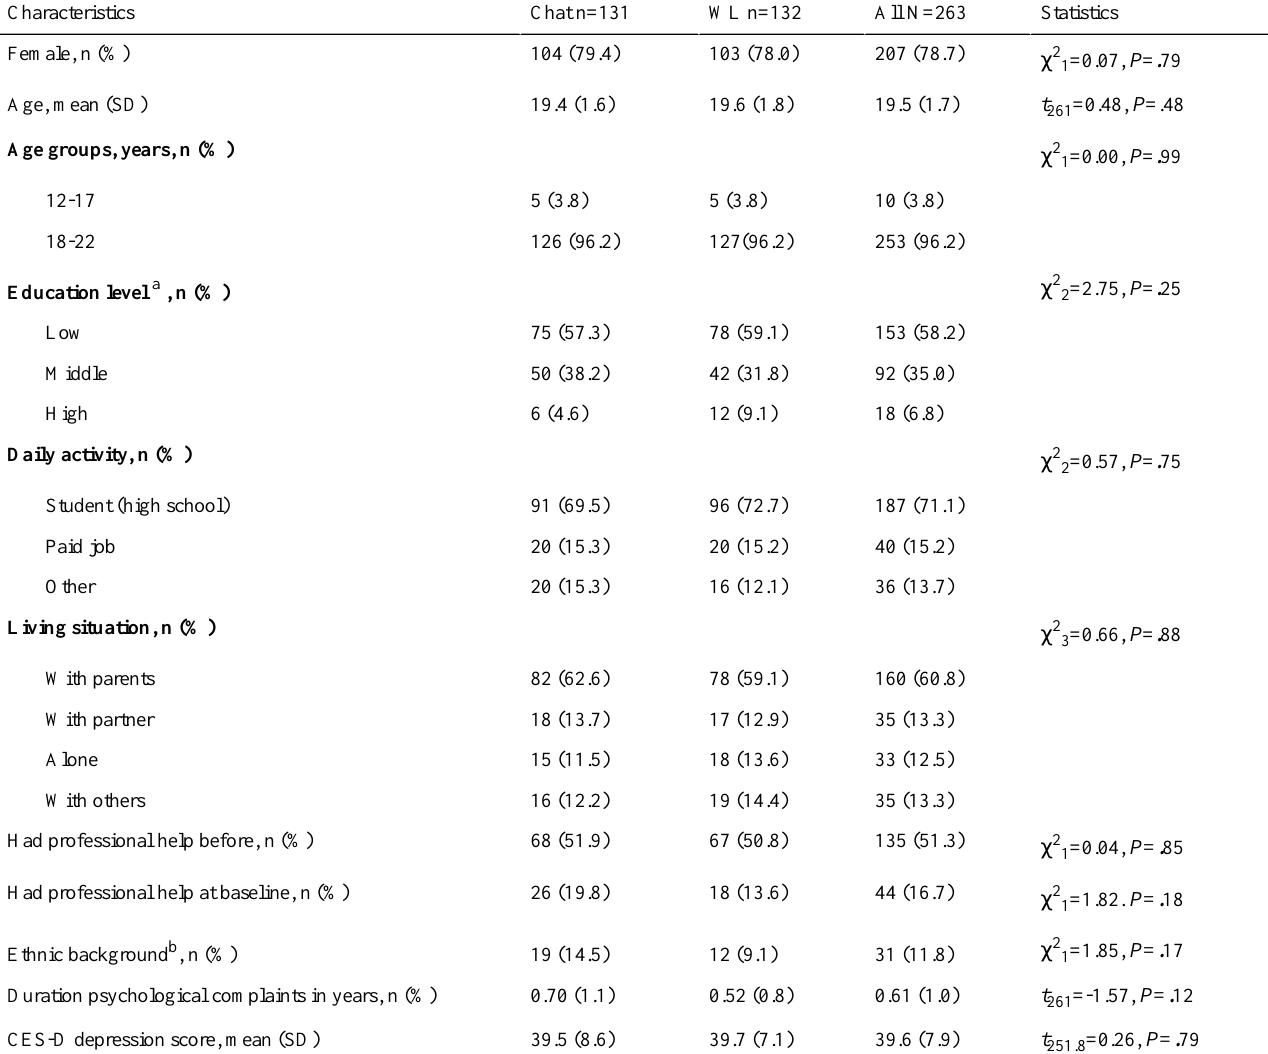
Table 1. Baseline characteristics (n=263).